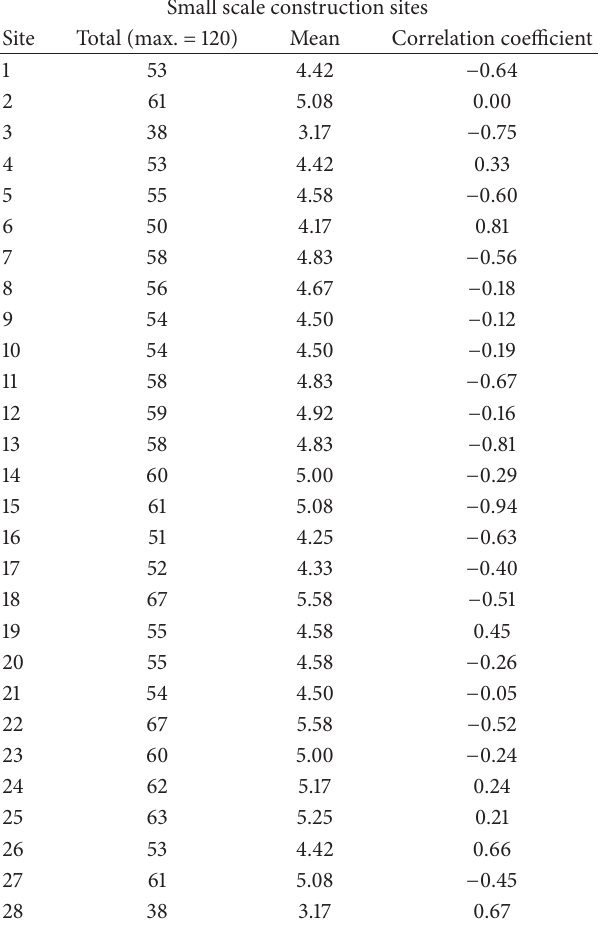
Table 1: Points obtained by small scale construction workers. Small scale construction